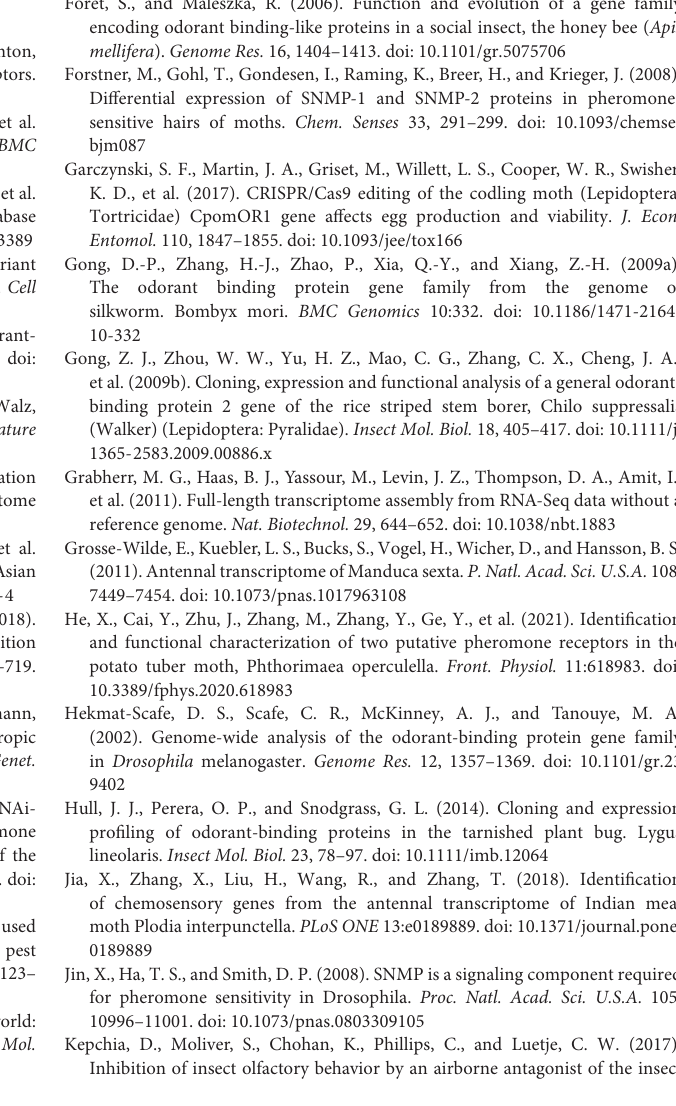
Supplementary Figure 3 | A comprehensive list of G. mellonella OBP , CSP , OR, and IR genes. Supplementary Figure 4 | Partial alignment of the protein sequences of G. mellonella OBPs.